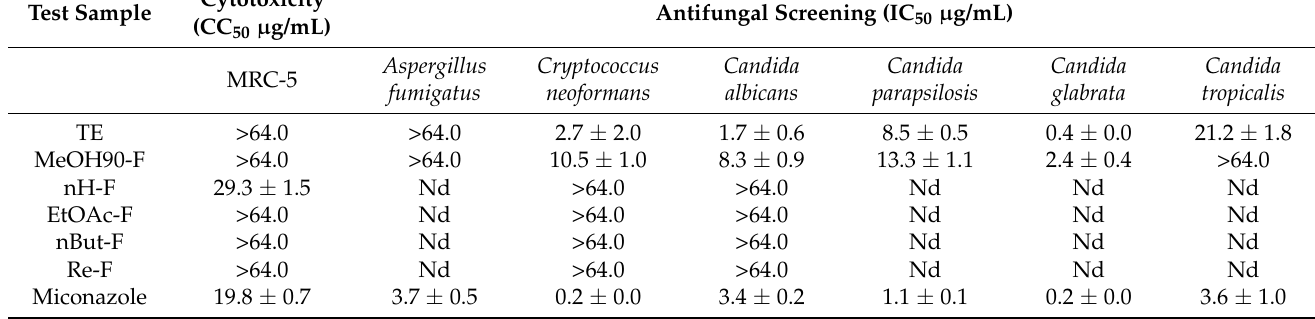
Table 1. In vitro antifungal and cytotoxic activity of the total extract and fractions from C. cowellii leaves. Test